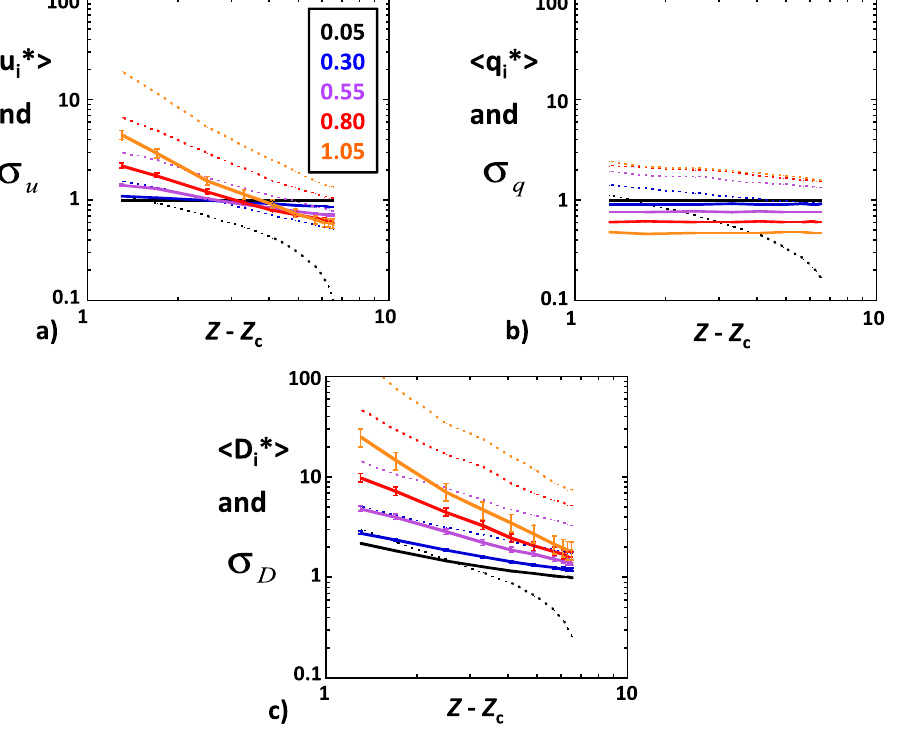
Figure 6. Means (solid lines) and standard deviations (dotted lines) of the distributions of the normalized pore velocities u i * ( a ), flow rates q i * ( b ) and Taylor dispersion coefficients D i * ( c ) as functions of Z − Z c from BCC simulations with CV values indicated in the